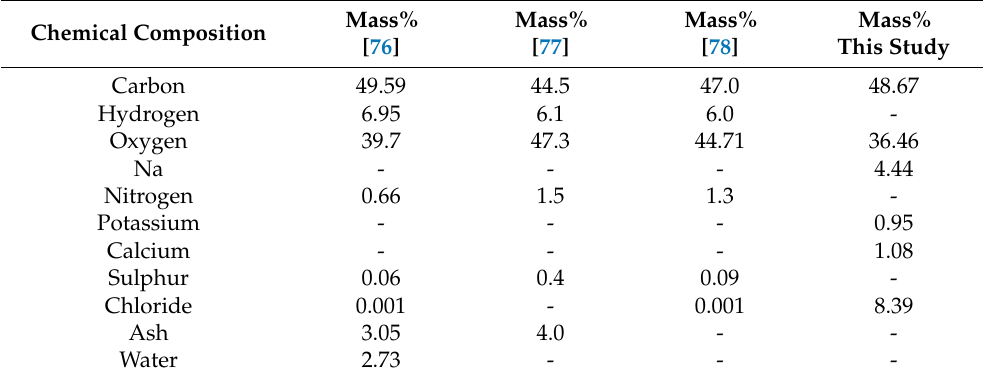
Table 3. Elemental composition of orange peel.